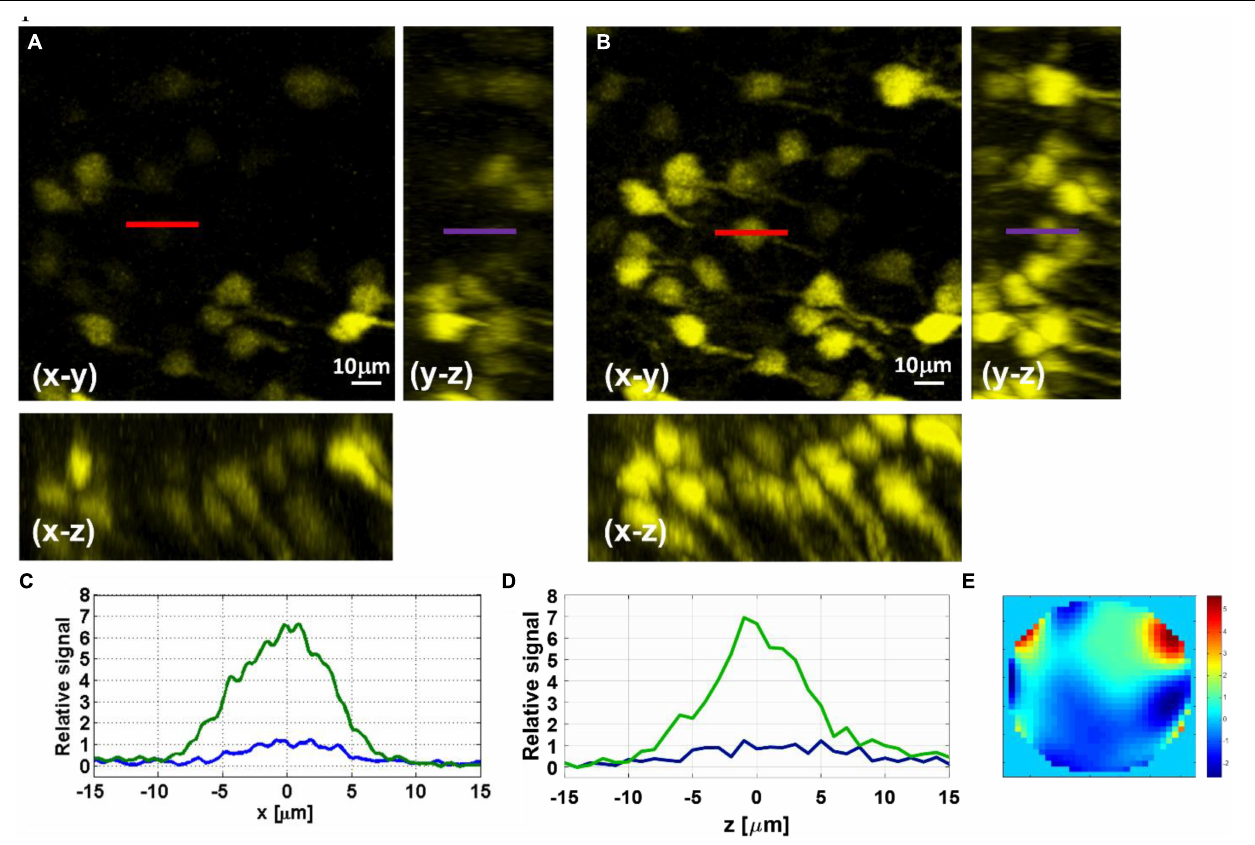
FIGURE 4 | Maximal-intensity projections of YFP-labeled hippocampus neurons at 1150–1100 µ m below the surface of the brain measured before (A) and after (B) AO correction. (C) Lateral line intensity profiles, marked in red in the x – y image, before (blue) and after (green) correction. (D) Axial line intensity profiles, marked in purple in the y – z image, before (blue) and after (green) correction. (E) Phase pattern applied with the SLM for the AO correction of the hippocampal